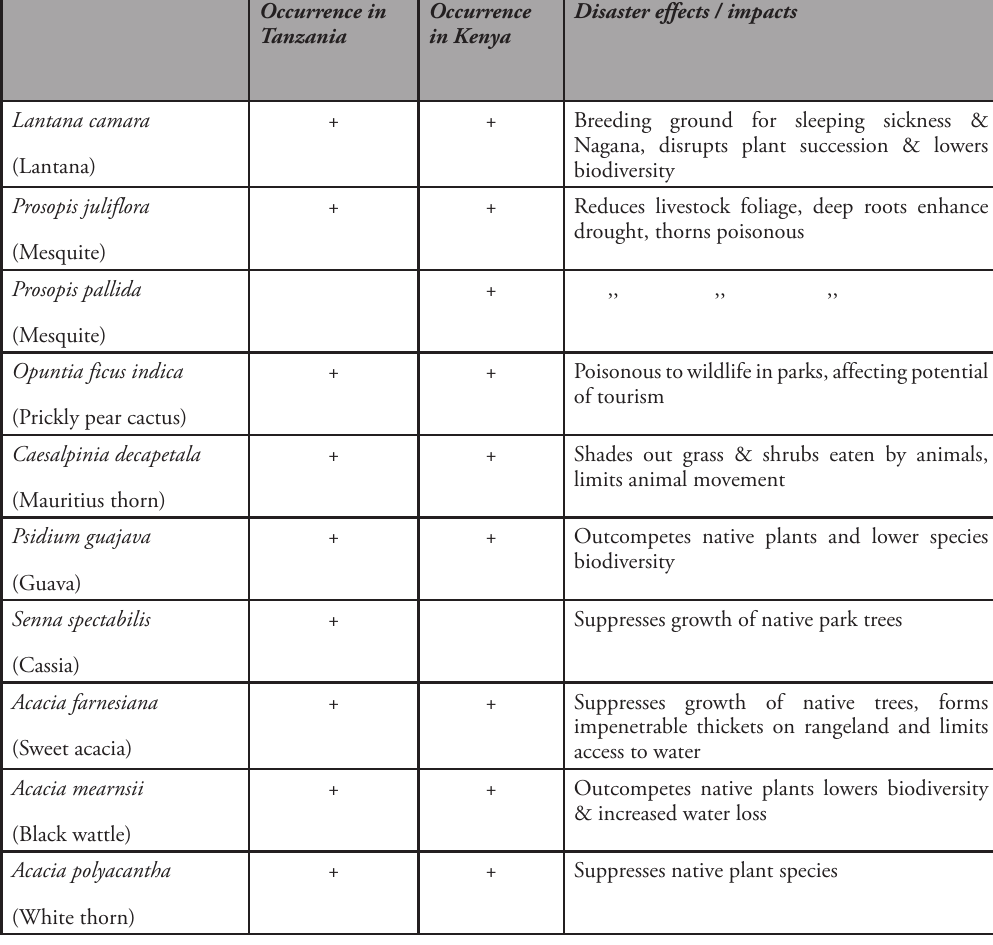
Table 1. Incidences of invasive plants and their disaster e ff ects in Kenyan and Tanzanian drylands. Plant occurrence indicated by the + symbol. Common names are put in